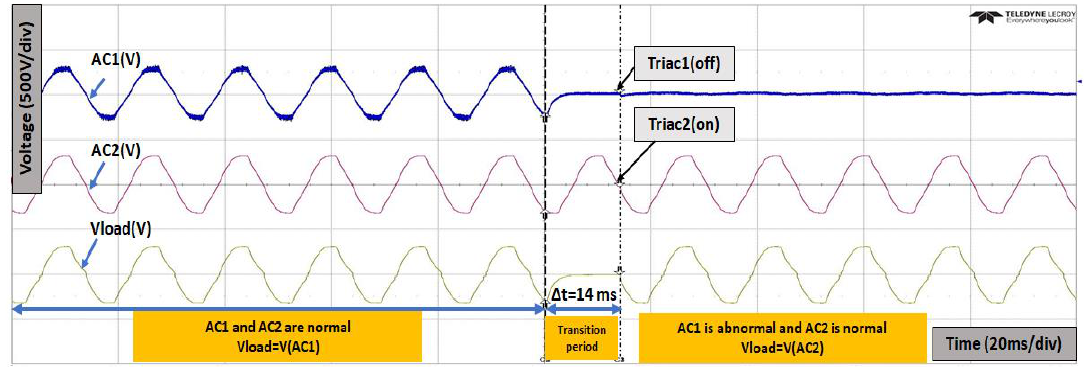
Figure 14. Experimental voltage waveforms and transition time calculations when the AC1 source is faulted during the voltage waveform rise time.